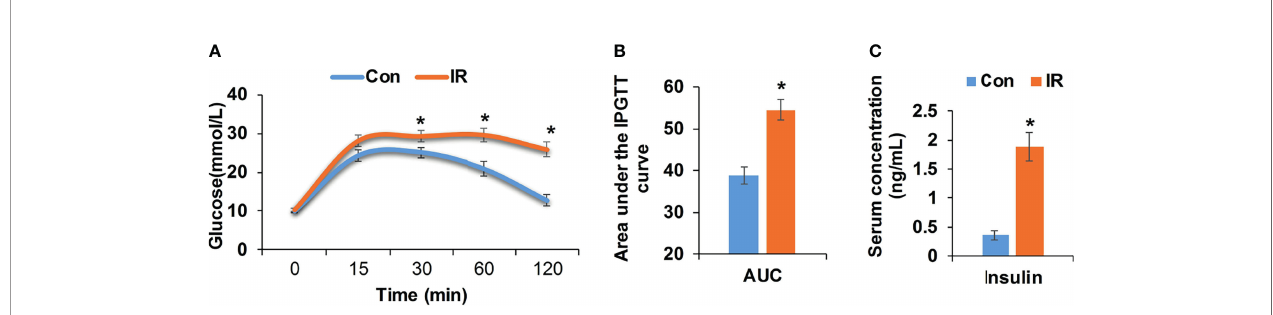
FIGURE 1 | Metabolic measurements of experimental mice. (A) Intraperitoneal glucose tolerance test (IPGTT, 2 mg/kg), age 21 weeks (Con, n = 12; IR, n = 9); (B) Area under the IPGTT curve; (C) Fasting insulin level of experimental mice, age 21 weeks (n = 6/group). *P < 0.05, compared to control group, Student ’ s t-test; the normality of corresponding data was determined by Shapiro – Wilk test (P >